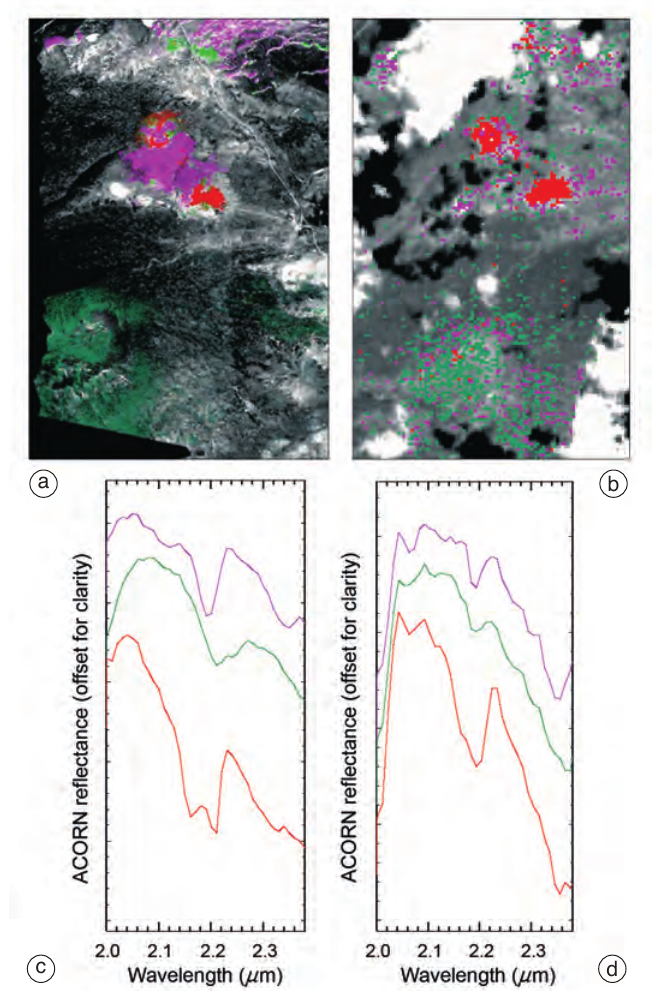
Fig. 6a-d. a) Image-map of selected endmembers from geocorrected AVIRIS SWIR data. Dark green is Cuya area with hydrothermal silica ± clay signature. Red is Kaolinite Hills area with kaolinite signature. Bright Green area is poorly crystalline kaolinite (spectrum not shown). Magenta shows areas with muscovite signatures. b) Hyperion grayscale image with MTMF mineral map overlay for the same approximate area: colors are the same as for AVIRIS. White areas are clouds and dark areas are cloud shadows. c,d) Hyperion endmember